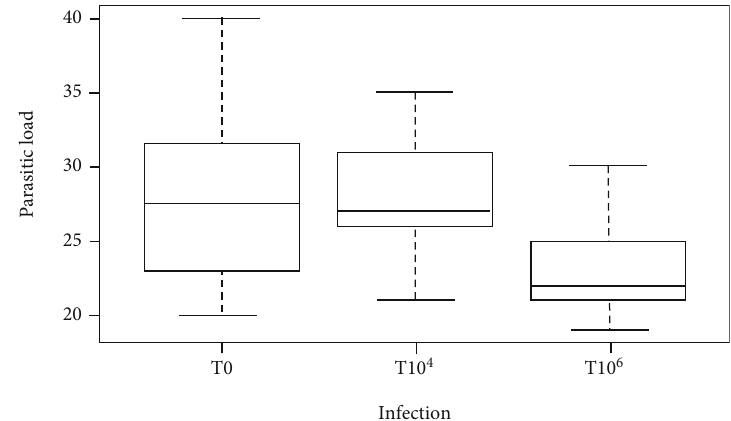
Figure 2: Ascaridia galli parasitic load in infective host groups with varying Salmonella typhimurium concentration. T of A. galli +0CFUs Salmonella typhimurium ; T galli +106 CFUs de Salmonella typhimurium .